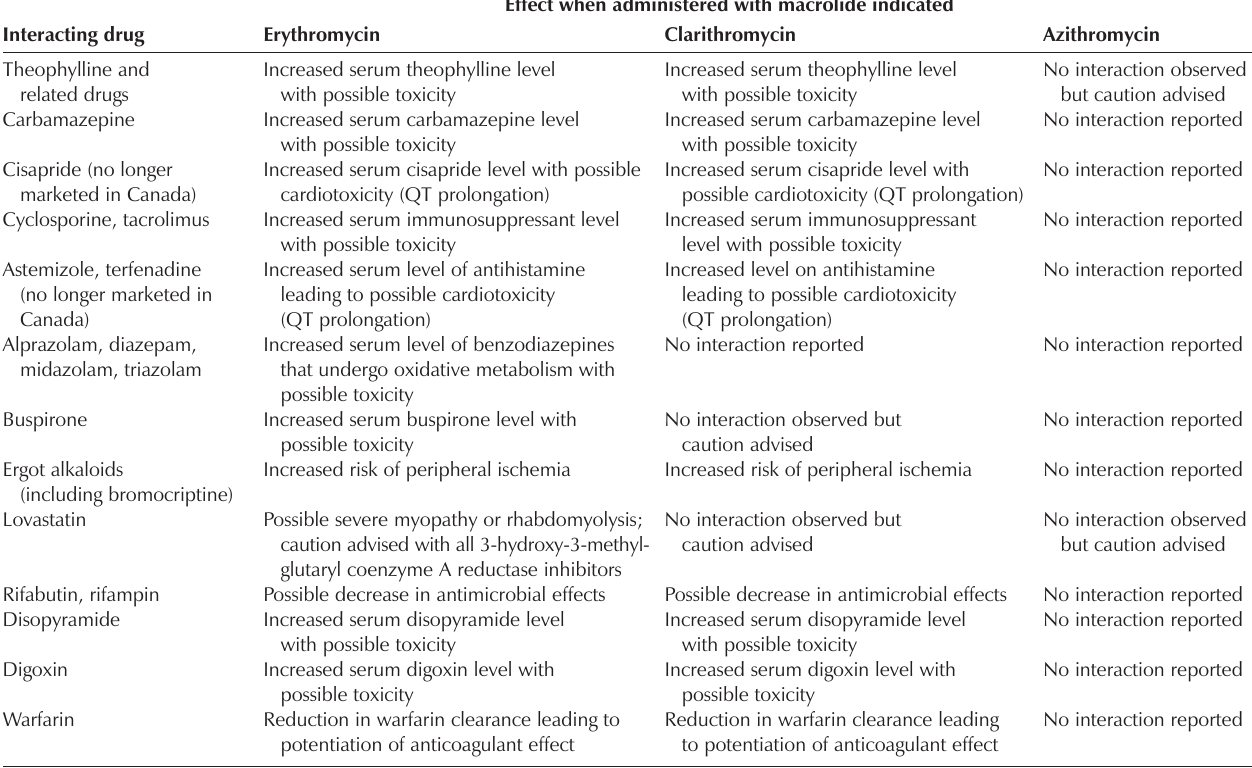
Potential clinically significant drug interactions involving erythromycin, clarithromycin and azithromycin Effect when administered with macrolide